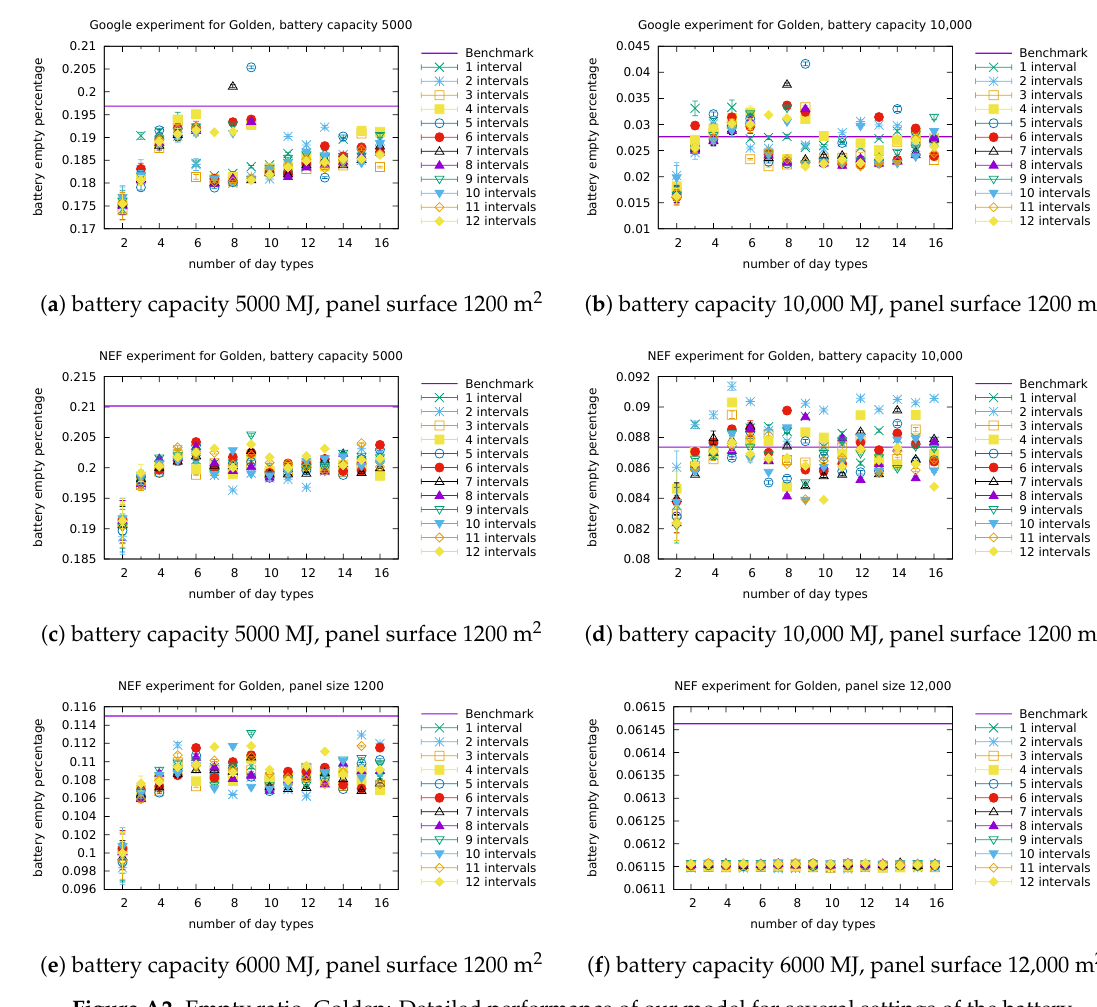
Figure A2. Empty ratio, Golden: Detailed performance of our model for several settings of the battery capacity and panel surface with Google consumer ( a , b ) and NEF consumer ( c – f